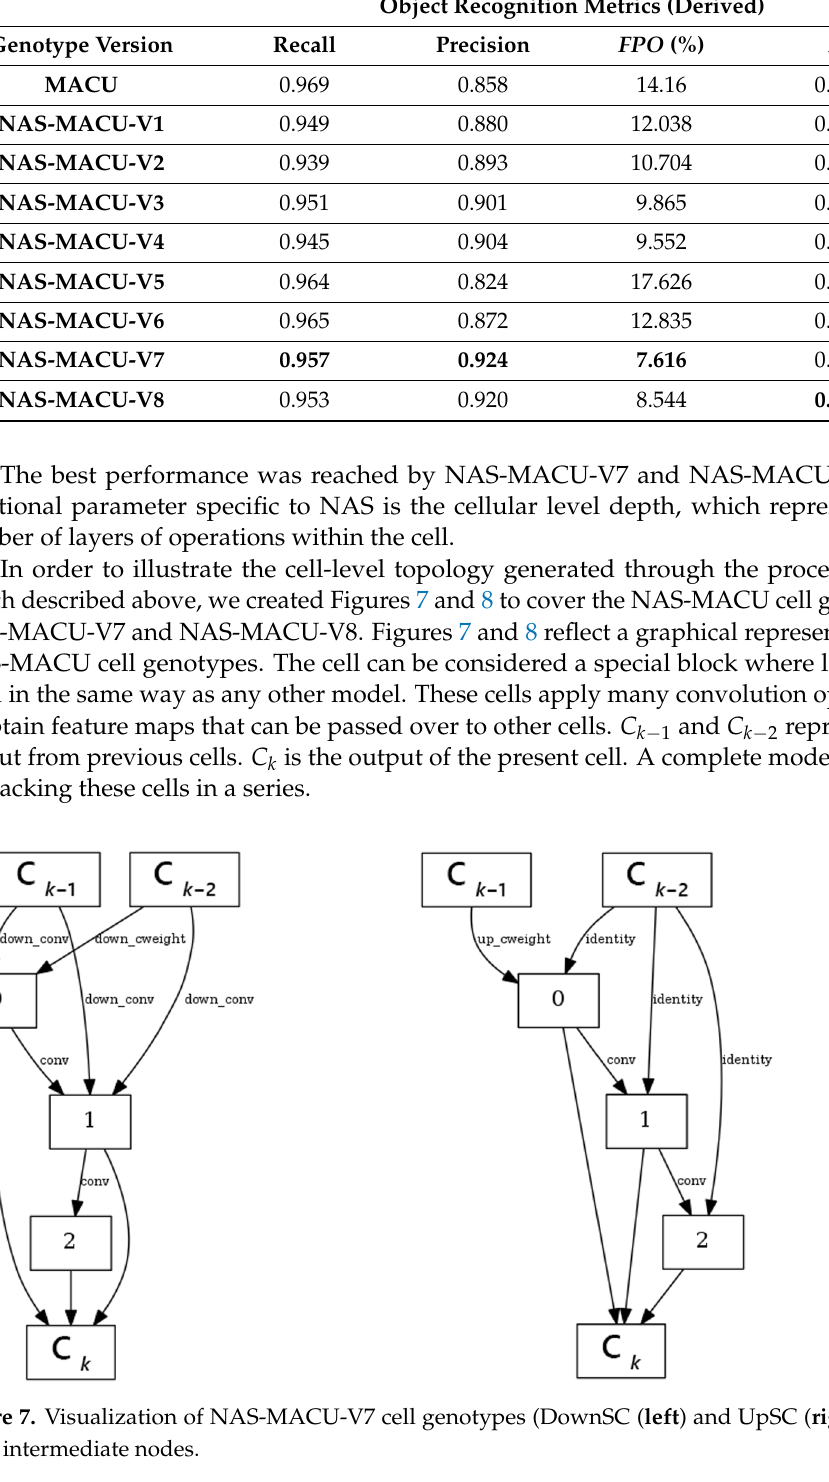
Figure 8. Visualization of NAS-MACU-V8 cell genotypes (DownSC ( left ) and UpSC ( right )) with)) with four intermediate nodes. It is important to mention that hyperparameters of the potential NAS-MACU geno- types’ search space can be expanded. For the purpose of this research and due to compu- tational limitations, we limited the cell search space, as illustrated in Table 4. There are techniques for hyperparameter optimization that are applied to neural network calibra- tion outside of NAS that could potentially be implemented here in NAS construction too, instead of manual selection. Even with these limitations, the computational time for each of the eight NAS-MACU experimentation cycles took 36 h on average. With additional computational resources, these NAS hyperparameters can be expanded, and further re- search could be conducted in order to achieve validation and potentially achieve even better performance. 5. NAS-MACU Performance Evaluation To evaluate the performance of NAS-MACU on the full dataset, eight genotypes were generated on the back of the different configurations, as described in Subsection 4.4.